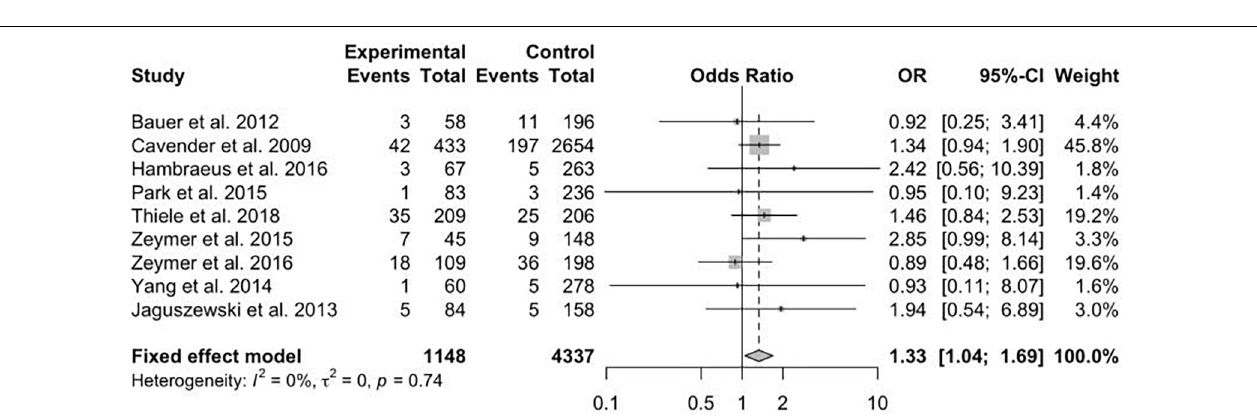
FIGURE 6 | Repeat revascularization reinfarction (MI) with multivessel (MV) vs. culprit vessel-only (CO) percutaneous coronary intervention (PCI) in patients with ST-segment elevation myocardial infarction (STEMI) complicated by cardiogenic shock (CS).